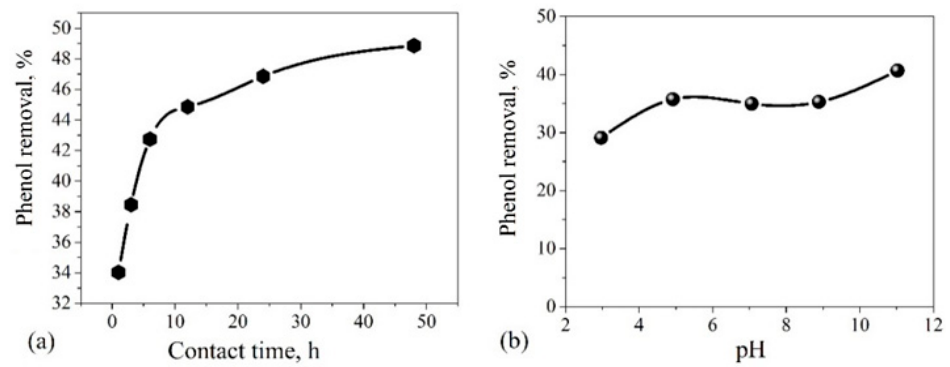
Figure 9. Effect of contact time ( a ) and pH ( b ) on the removal of phenol by TBC-0.5 (C 0 = 20 mg/L, m = 10 mg, V s = 5mL). Table 4. Isotherm parameters for adsorption of MB from water solutions.